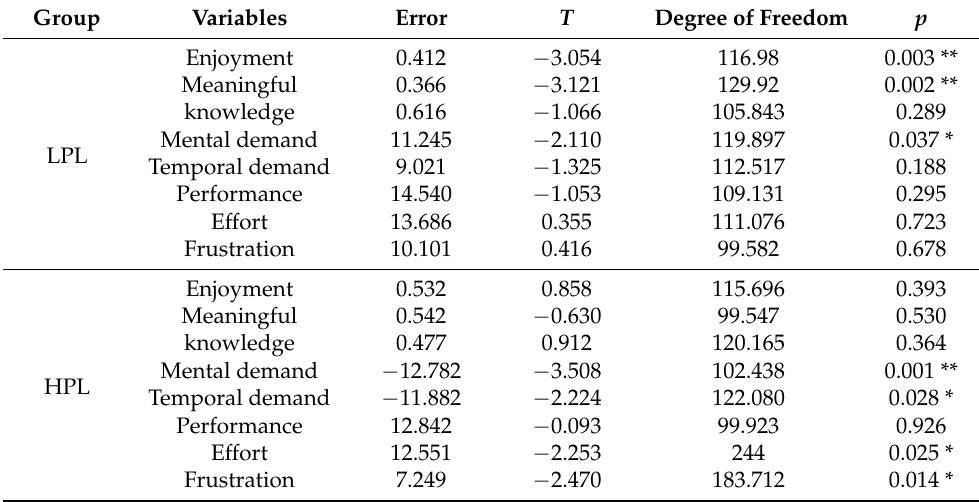
Table 1. Results of ex ante comparison between the two scales with and without the provision of visualized information (Statistical